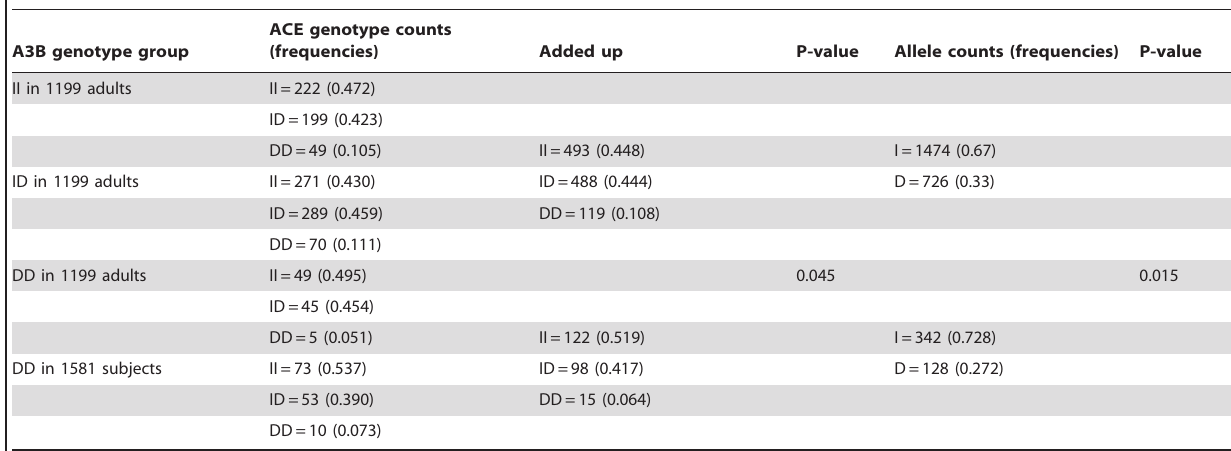
Table 2. ACE genotype/allele distributions in different A3B genotype groups.